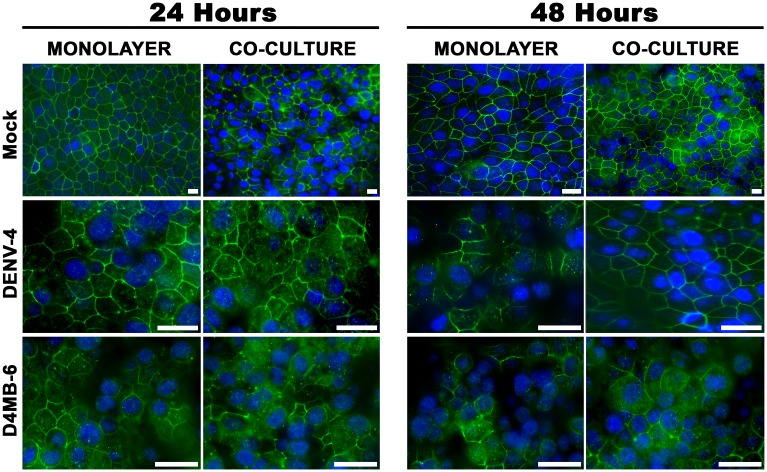
ZO-1 protein redistribution at 24 and 48 h p.i., in DENV infected MBECs.ZO-1 fluorescence pattern (green) in both barrier models infected with DENV-4 and D4MB-6 virus strains were evaluated one, and two days post infection. DENV-4 parental virus infection at 24 h p.i. did not affect the ZO-1 pattern in MBEC cells neither in monolayer barrier model nor in co-culture barrier model. On the contrary, neuroadapted dengue virus induced a ZO-1 re-localization from the cell margin to cytoplasm leaving a disrupted linear fluorescence pattern in the membrane. At 48 h p.i. both viruses induce cell detachment, however in the MBEC monolayer model was more severe with great cell loss and full ZO-1 rearrangement. Bar = 20 μm.